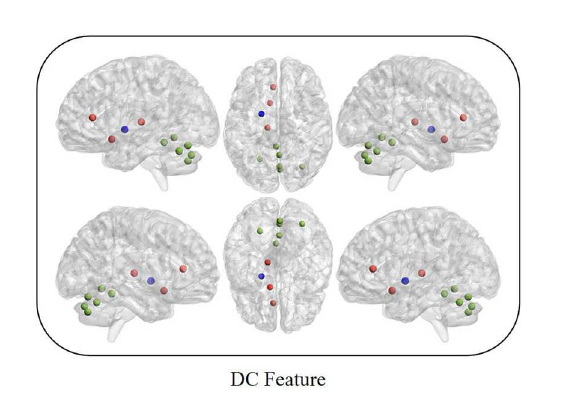
FIGURE2 Red represents the default mode network; Blue represents the basal node network; Green represents the cerebellum